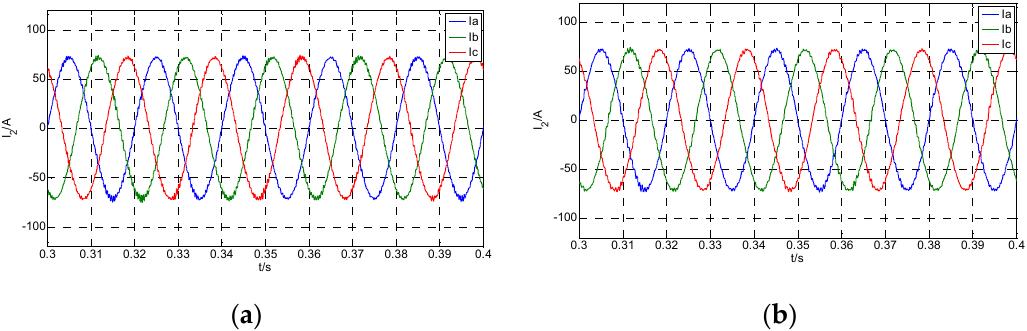
Figure 7. Steady-state current waveforms of voltage source inverters (VSI) based on two control schemes: ( a ) Output current of the single closed-loop control system, ( b ) output current of the double closed-loop control system.